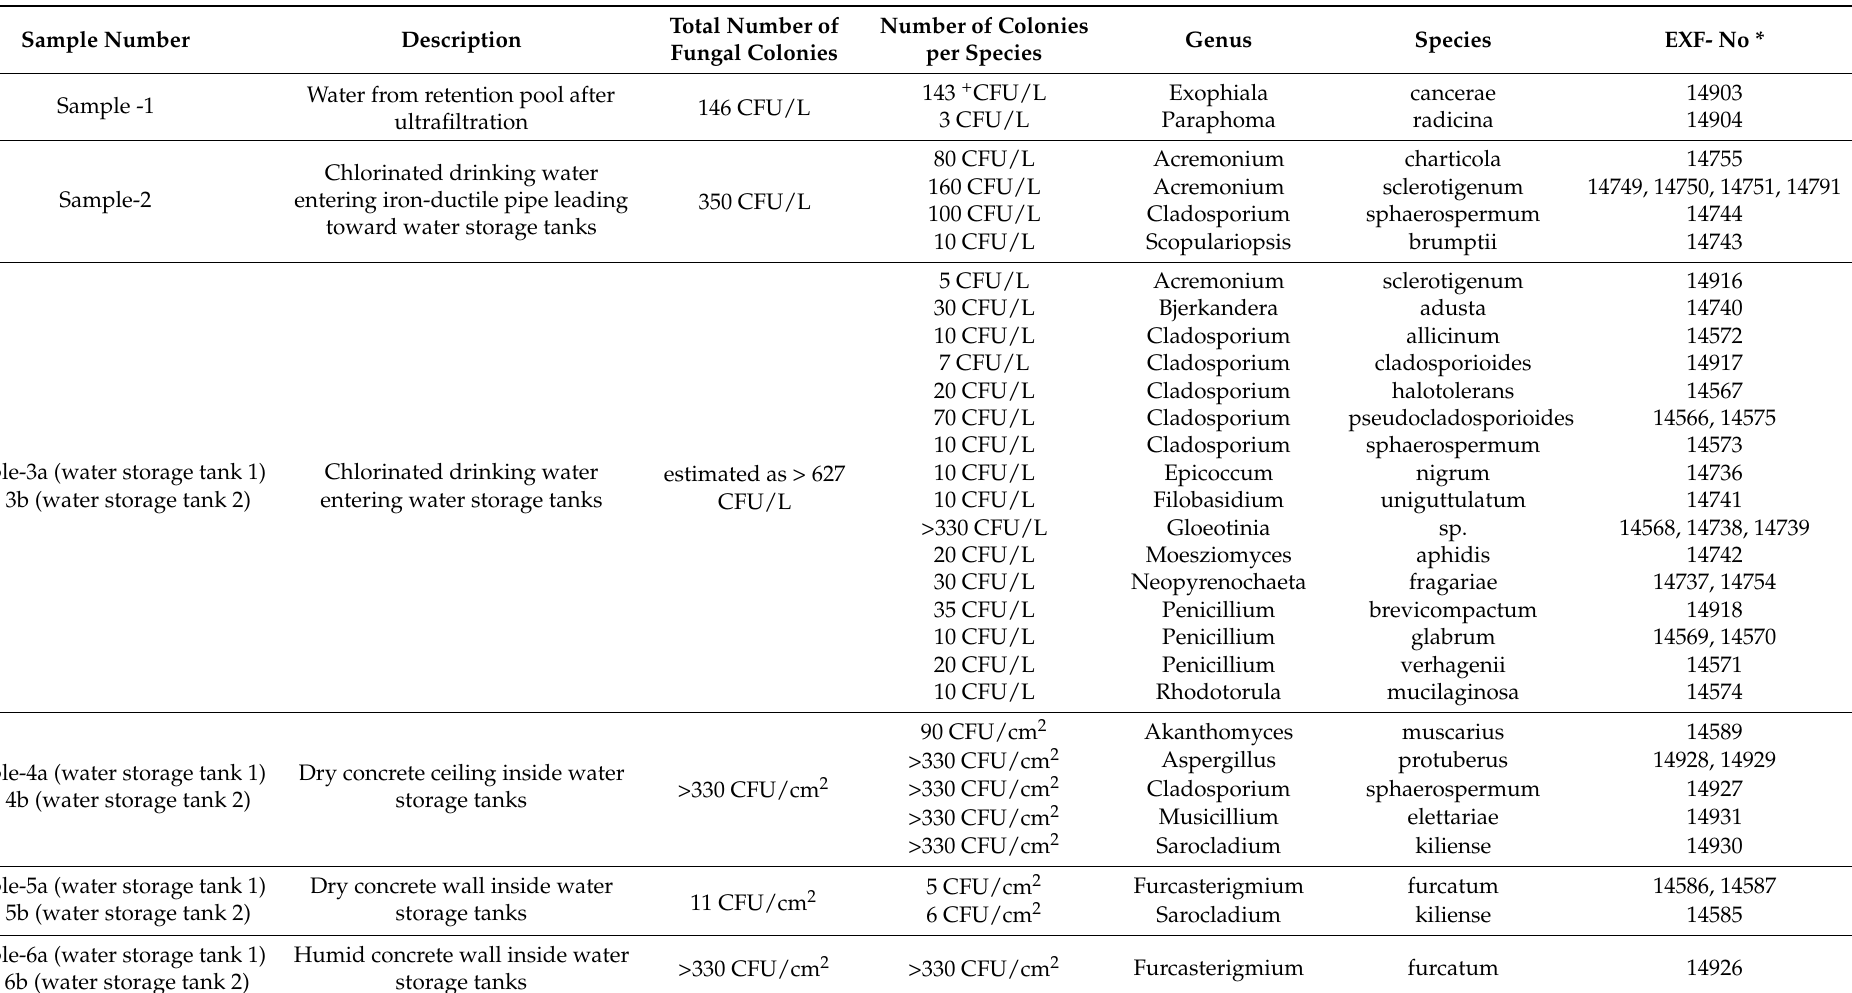
Table 1. Number and diversity of fungi isolated from drinking water through distribution network and from concrete water storage